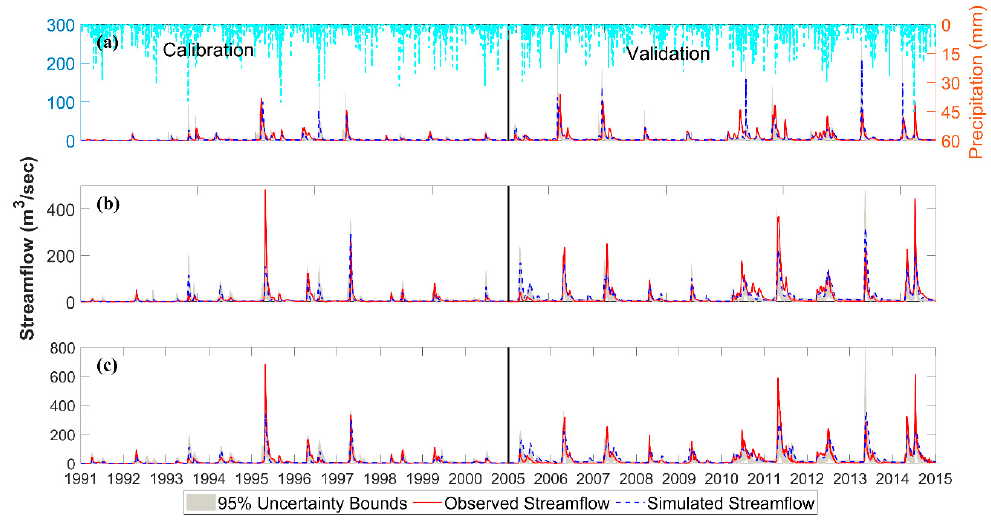
Figure 4. Calibration and validation result for the Upper Assiniboine River basin at ( a ) upstream catchment (WSC station ID: 05MC001) with precipitation on the secondary axis, ( b ) mid-stream catchment (WSC station ID: 05MD004), and ( c ) lower stream catchment or reservoir inflow gauging point (HFC station ID: 05MB999).